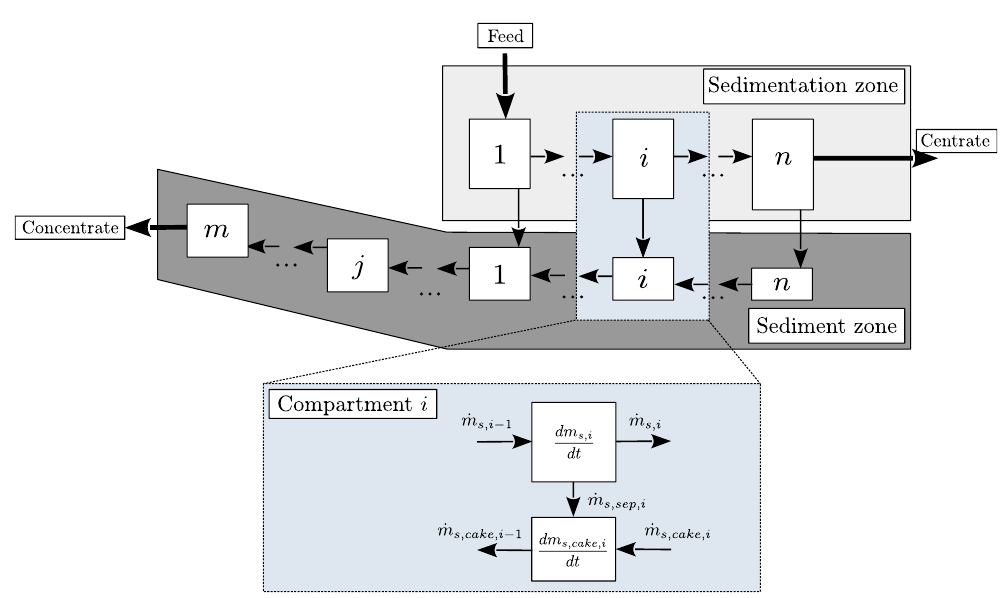
Figure 5. Schematic representation of the structure of the multi-compartment model of a counter– current decanter